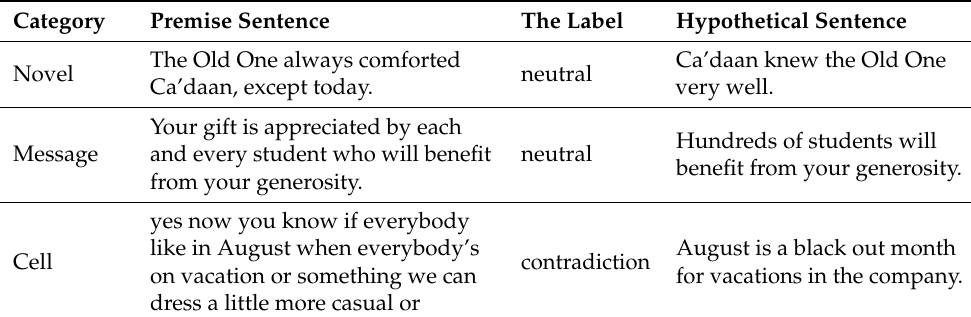
Table 2. Sample data of Multi-NLI